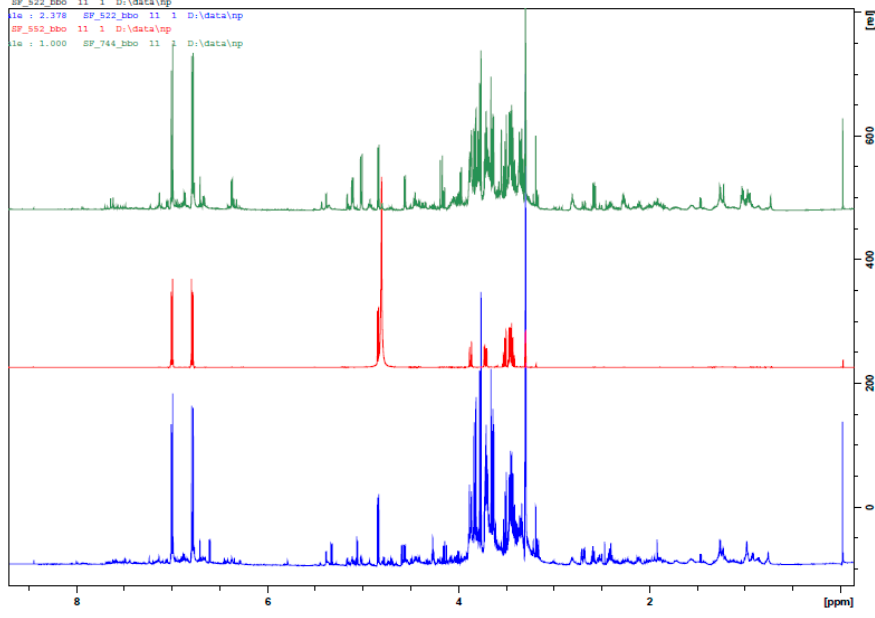
Figure 1. 1 H NMR spectra of Vau-1 (blue), pure arbutin (red) and Vau-2 (green). Table 2. Calculations for arbutin concentrations in V. austriaca L. extracts. Concentration of Extracts Arbutin in